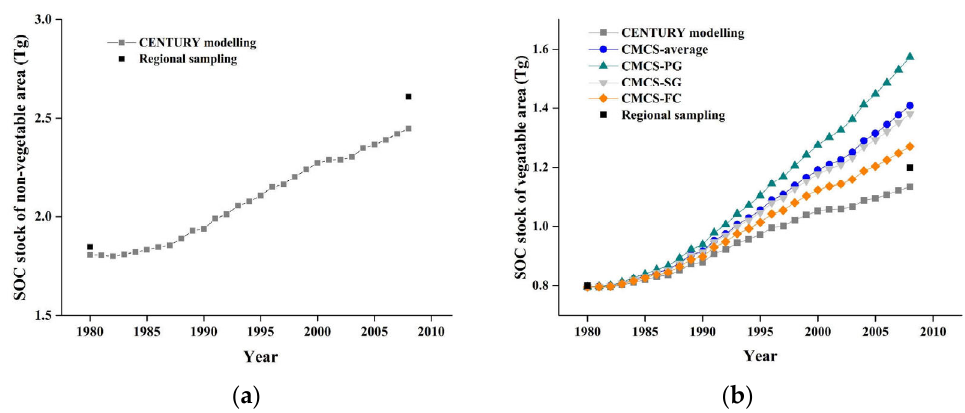
Figure 4. Comparison of soil organic carbon (SOC) stocks of ( a ) non-vegetable area; and ( b ) vegetable area in Cangshan County. CMCS represented the framework combining CENTURY modeling and chronosequences sampling. PG, SG, and FC represent perennial greenhouse, seasonal greenhouse, and field cultivation, respectively.